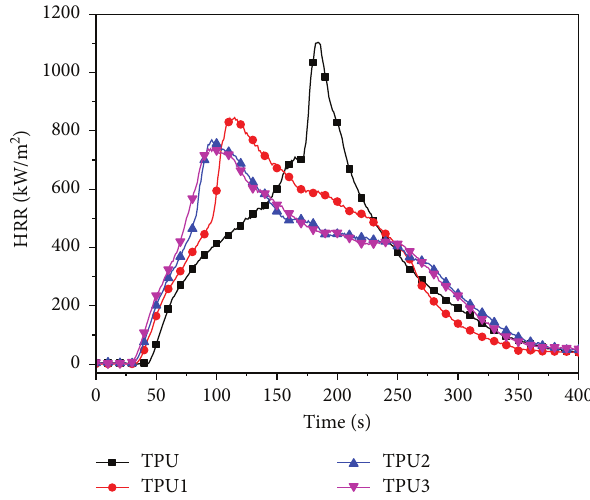
Figure 5: HRR curves of TPU and TPU composites.